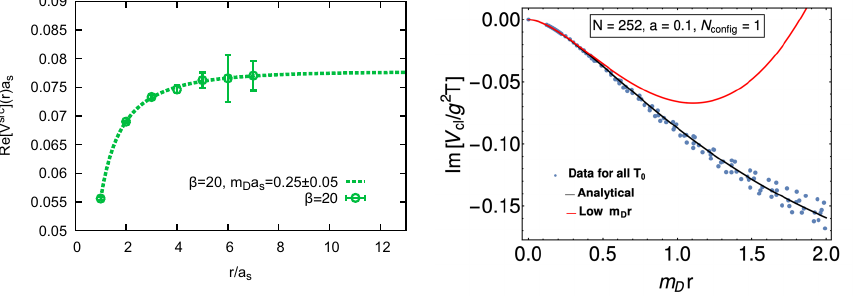
Figure 3. (left) Real part of the static interquark potential in thermal classical lattice gauge theory [35], which is compatible with the expected Debye screening behavior in a gluonic plasma at high temperatures. (right) A high precision analysis of the imaginary part of the interquark potential in CLGT on large lattices [37] and a comparison to a fit motivated by analytic predictions from classical hard thermal